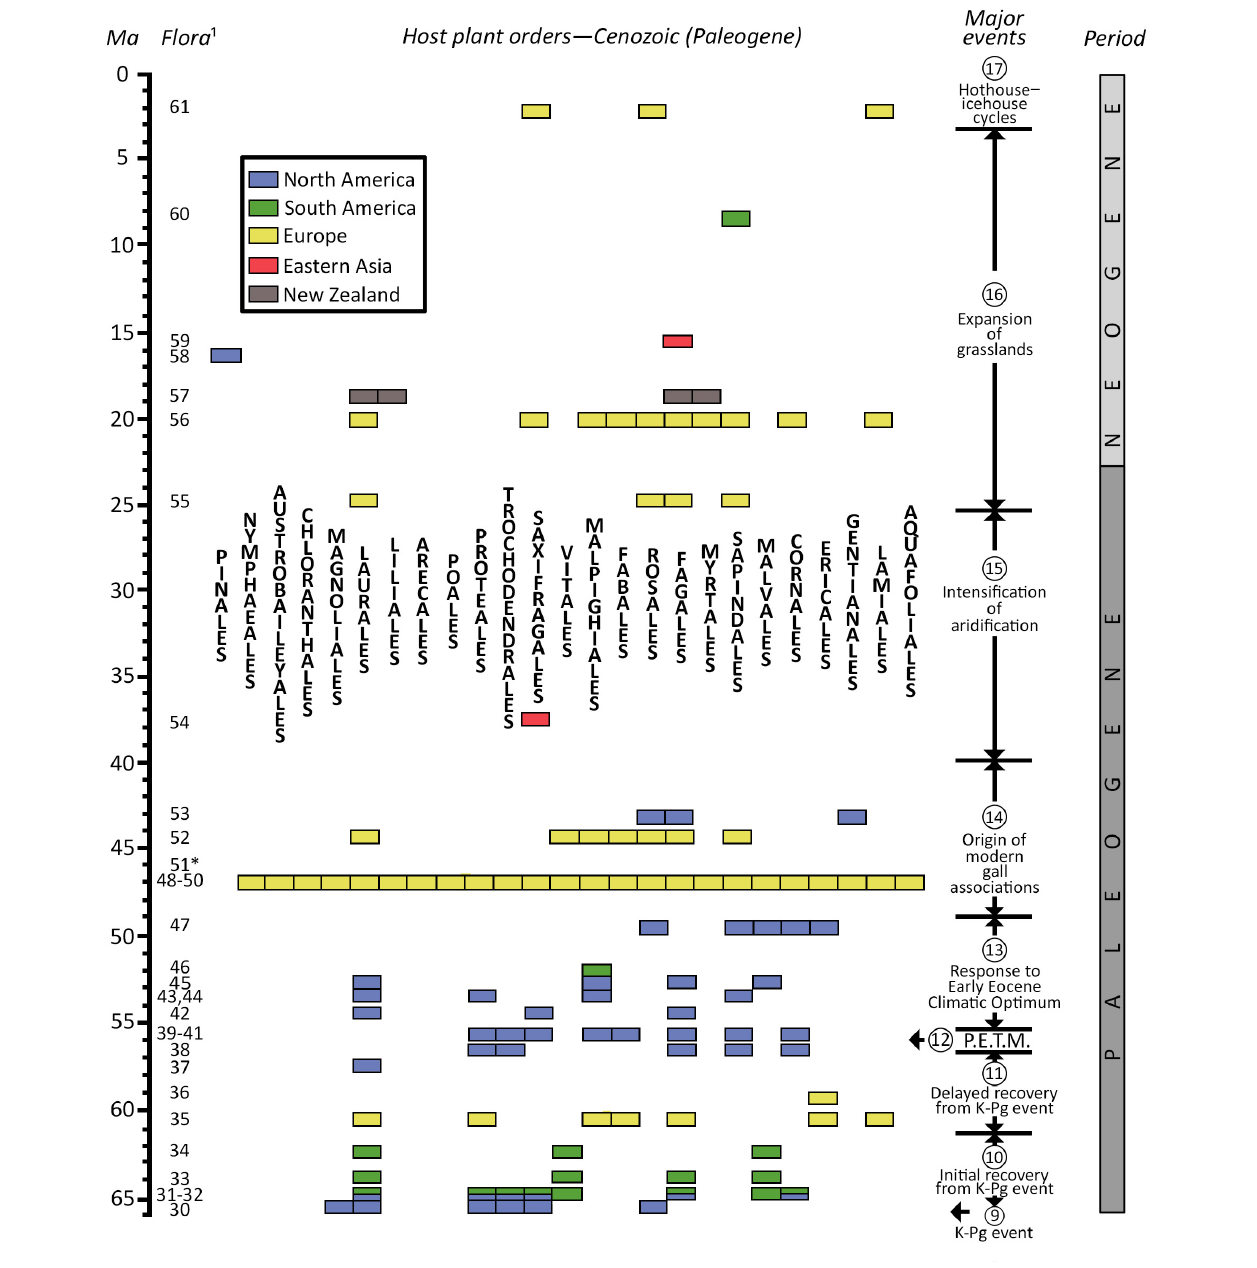
FIGURE 5 | Biogeographic distribution and major events affecting gall-bearing, host-plant orders through the Paleozoic and Mesozoic eras. See Supplementary Appendix 3 for documentation for flora numbers at left. Time scale after Walker et al. (2018).